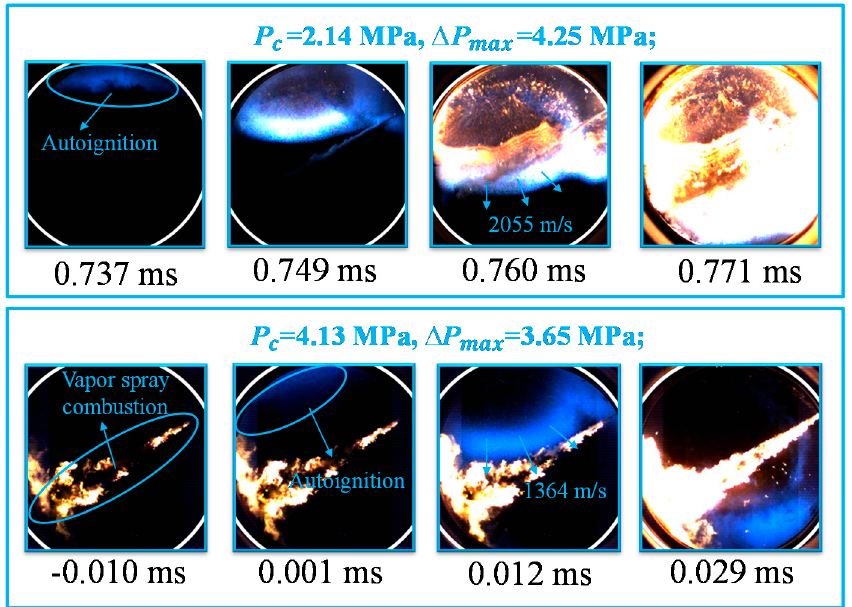
Figure 10. Selected images of combustion evolution under the conditions of FIP = 50 MPa and ∆ t = 2.0 ms.